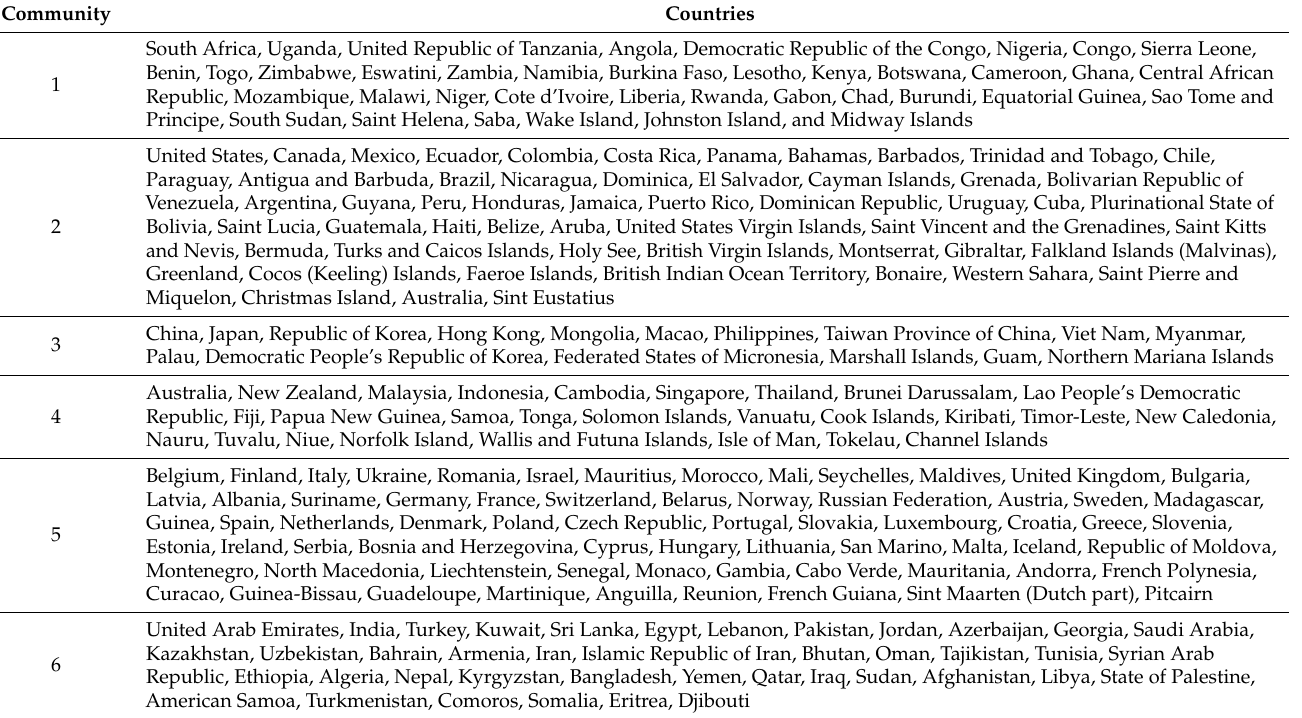
Table 2. Communities in the world tourism